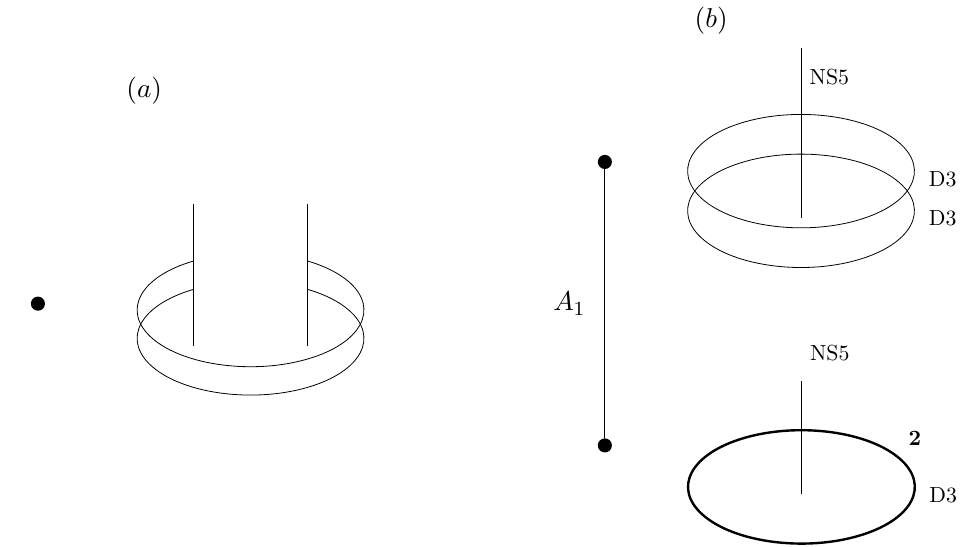
Figure 8. Brane systems for the two theories ( a ) and ( b ) along with the 3d N = 4 Coulomb branch Hasse diagrams. In case ( a ) the Coulomb branch is smooth so the Hasse diagram is a point. In case ( b ) there are two leaves. The bottom diagram shows the two coincident D3